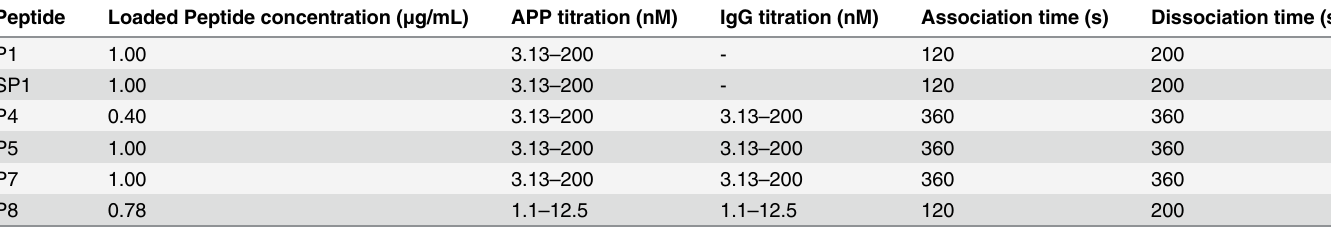
Table 2. Assay Conditions For The Interaction Of Each Peptide With APP Or IgG. Peptide Loaded Peptide concentration ( μ